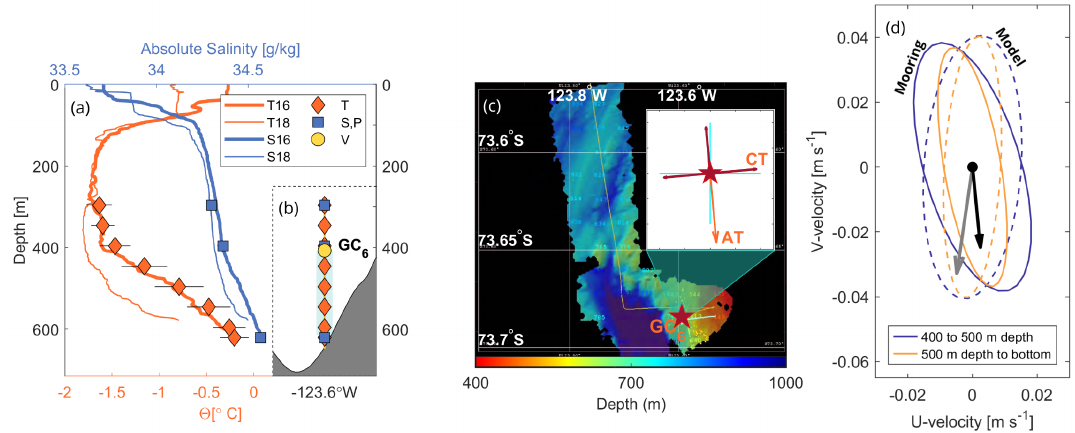
Figure 2. (a) Profiles of conservative temperature (orange) and absolute salinity (blue) obtained from CTD casts at deployment (thick lines) and recovery (thin lines) of mooring GC 6 . Mean temperature (orange diamonds) and salinity (blue squares) recorded by each instrument on GC 6 with standard deviation (black lines) is marked. The standard deviation for salinity is too small to be seen outside the blue boxes. (b) Instrument levels for temperature, salinity, pressure, and velocity (with the range in light blue) on GC 6 . The gray patch shows approximate bathymetry (based on the IBCSO dataset). (c) Bathymetry in the trough from multibeam recordings (adapted from Lee, 2016) with the location of GC 6 marked by the red star. The rotation of the coordinate system at GC 6 from cartesian coordinates (cyan lines) to coordinates based on the mean current direction (red lines) is indicated in the inset. The orange arrow shows the mean current direction (AT: along- trough), whereas CT denotes the cross-trough direction. (d) Velocity variance ellipses from 407m (ADCP instrument depth) to a depth of 500m (blue) and below a depth of 500m (orange). Solid lines for the mooring and dashed lines for the regional model’s daily output. The total mean velocities for observations and model are indicated by black and gray dots with arrows